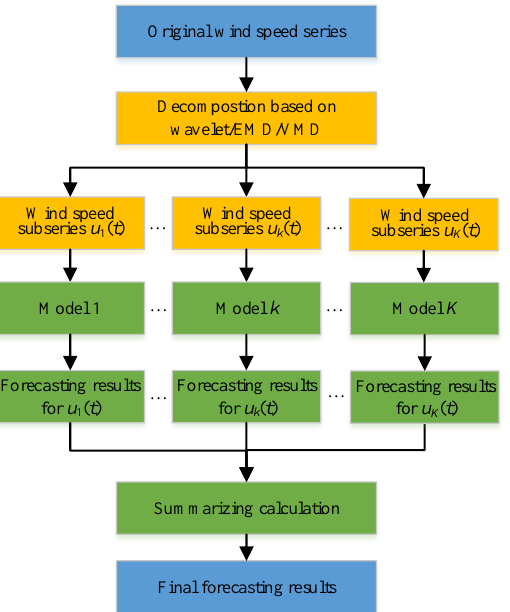
Figure 3. Framework of traditional decomposition – combination wind speed forecasting model.